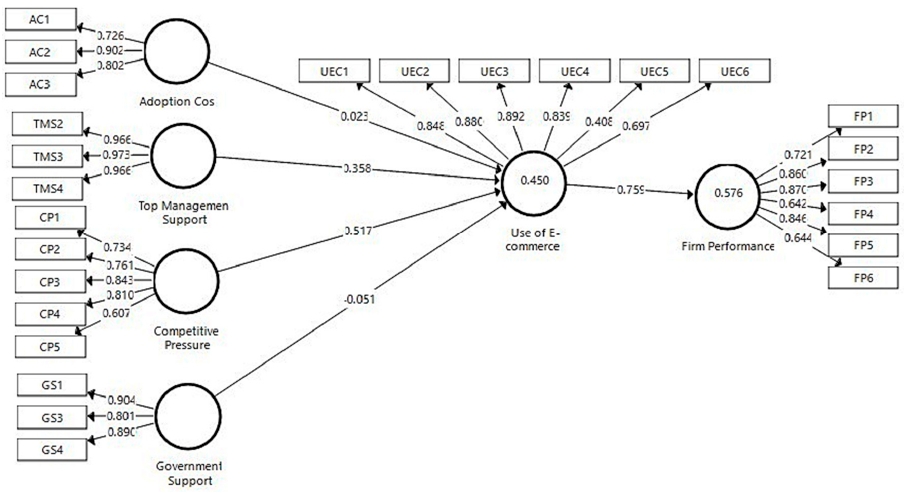
Figure 3. The PLS algorithm of the measurement model.